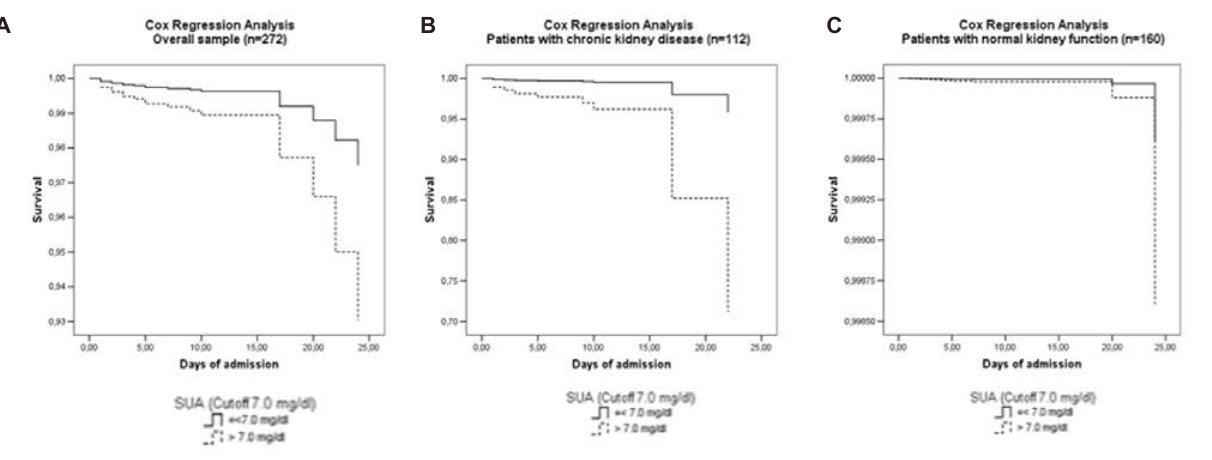
Figure 1. Cox proportional hazards model survival function in the complete sample (A), in the subgroup of patients (B) affected by chronic kidney disease, and with normal renal function (C), adopting a serum uric acid cut-off ≤ 7.0 mg/dL.